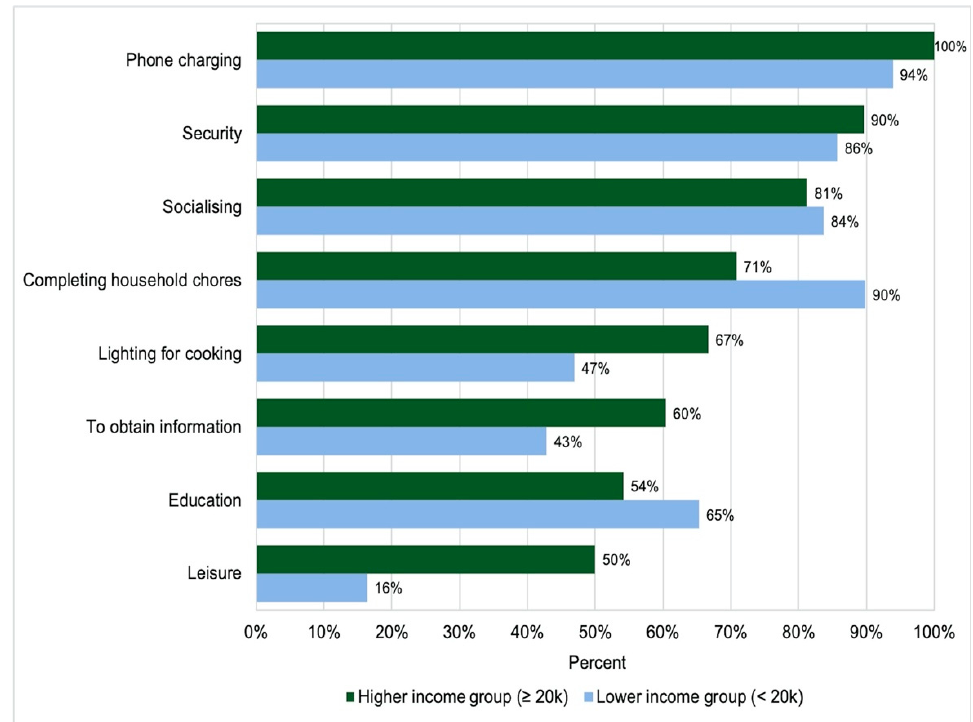
Figure 5. SHS activities split by income.